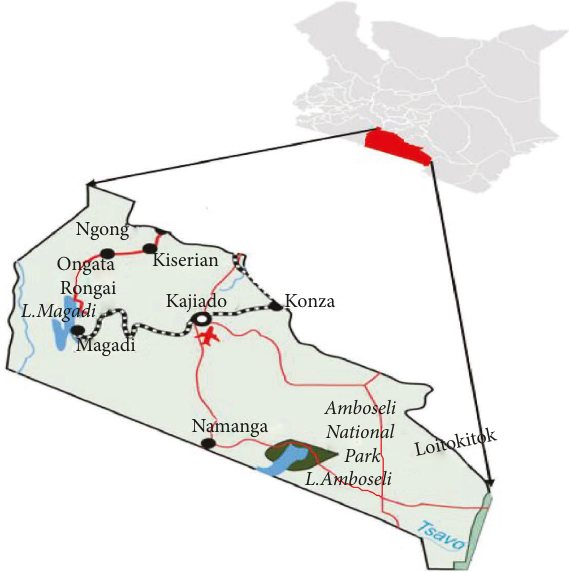
Figure 1: Map of Kajiado County and its location in Kenya (shaded